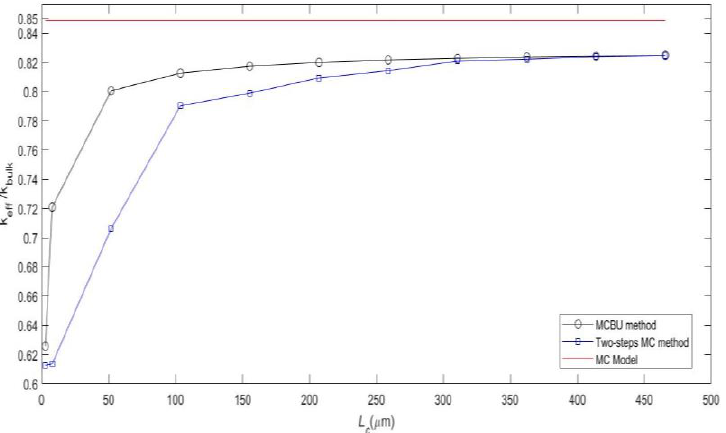
Figure 2. The effective thermal conductivity computed using the MCBU method, the two-step MC method and the MC model.